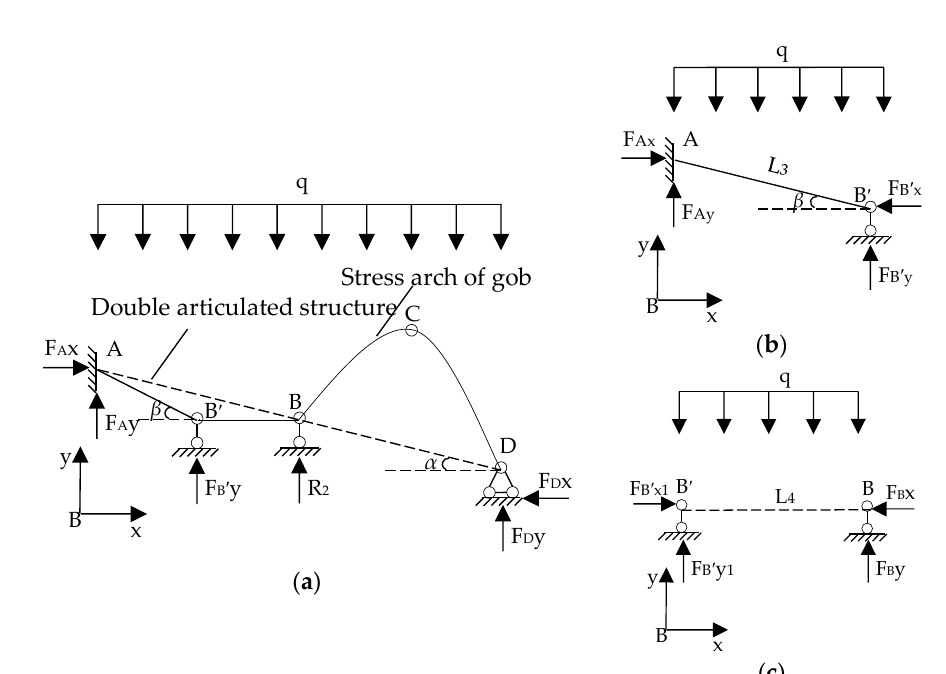
Figure 4. Roof inclined fracture structure of medium width working face. ( a ) Mechanical model of double-articulated–multi-articulated structure; ( b ) double-articulated left end structural isolator; ( c ) double-articulated right end structural isolator.